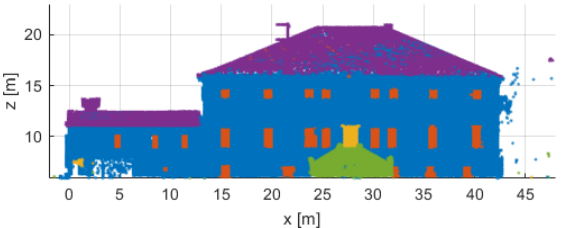
Figure 6. Predicted semantic segmentation of Villa Roberti Bru- gine: most popular vote approach.